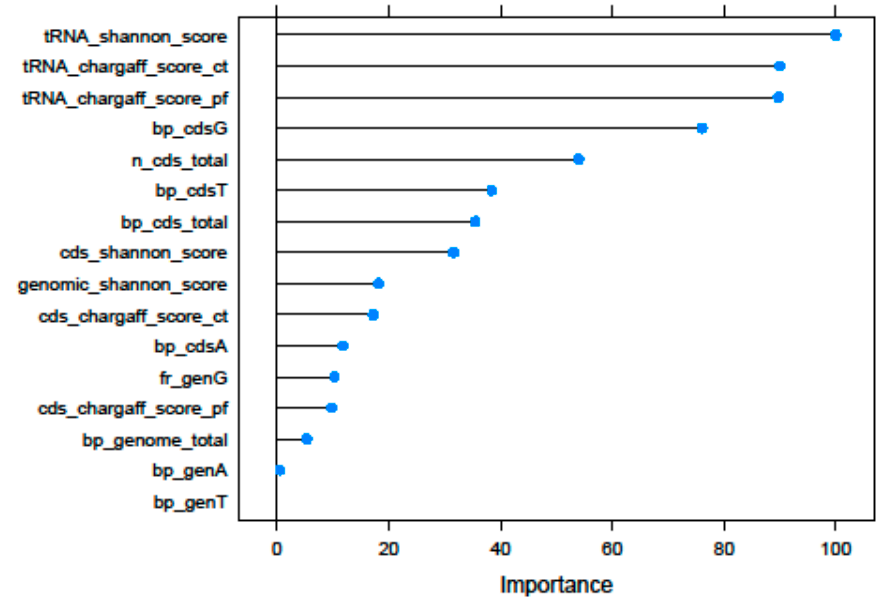
Figure 2. Feature importance plot showing the ranking of the selected features for the prediction of the probiotic/non-probiotic status, using NN as predictive method. Detailed information of the genomic features is fully explained in File S1.